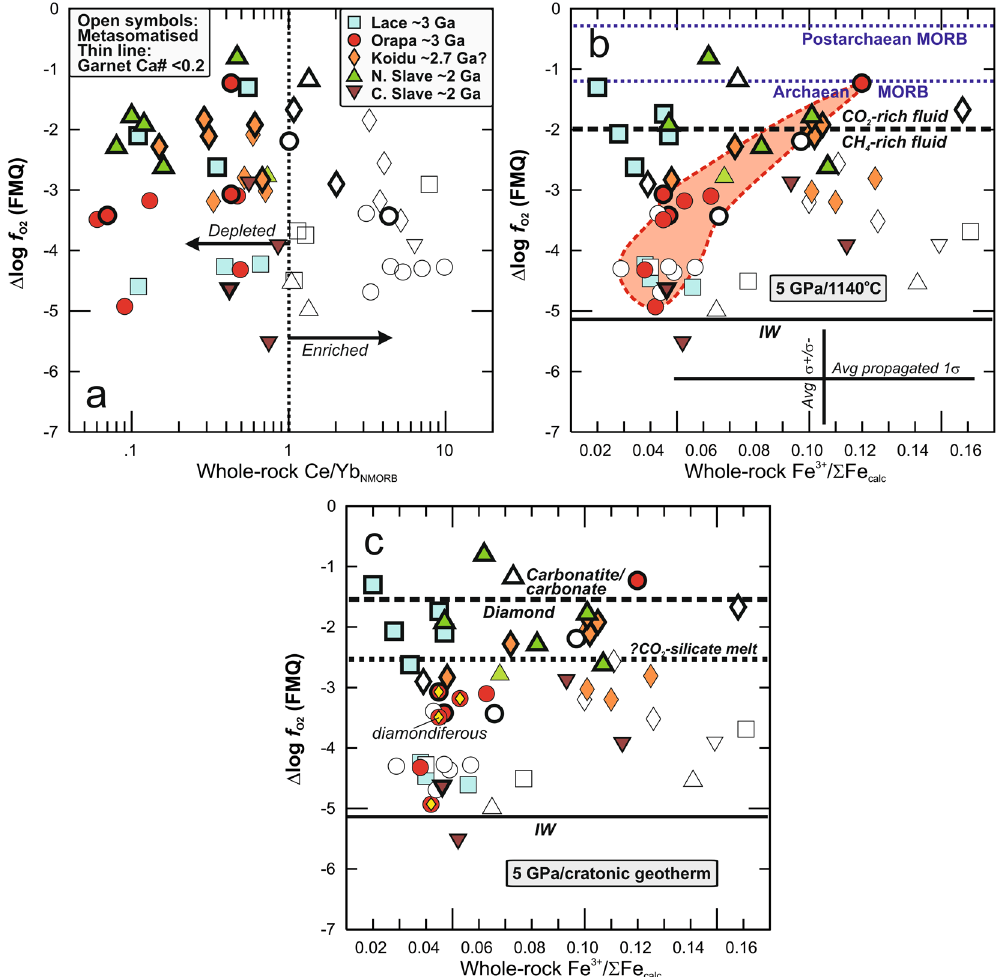
Figure 4. Oxygen fugacity estimates for mantle eclogite. Oxygen fugacity using the oxybarometer of 16 and denoted as ∆ log ƒ O 2 (FMQ), i.e. calculated relative to the fayalite-magnetite-quartz buffer, as a function of ( a ) NMORB-normalised Ce/Yb in reconstructed whole rocks (as in Fig. 1) and ( b,c ) Fe 3 + / Σ Fe in reconstructed whole rocks. Error bars on Fe 3 + / Σ Fe reflect average propagated uncertainties as described in Fig. 1, on ∆ log ƒ O 2 they reflect average uncertainties propagated from those on garnet Fe 3 + / Σ Fe ( ± 0.01). The symbols of samples with compositions far from the end-members on which the oxybarometer was formulated are shown with thin outline (see Methods). Thick stippled line in ( b ) separates CH 4 -dominated from CO 2 -dominated diamond-saturated fluid; ƒ O 2 corresponding to the iron-wuestite (IW) oxygen buffer is also shown (at 5 GPa and 1140 °C 31 ). Thin blue stippled lines show Δ log ƒ O 2 of post-Archaean and Archaean MORB-equivalents with FMQ-0.26 ± 0.44 and FMQ- 1.19 ± 0.33, respectively 8 . The majority of samples have lower ƒ O 2 than Archaean or modern MORB, requiring reduction of their protoliths upon subduction. Thick stippled line in ( c ) separates carbonatite melt or carbonate from graphite or diamond (at 5 GPa along a cratonic geotherm 13 ). Most Palaeoproterozoic and Archaean eclogites at mantle depth would not be in equilibrium with pure carbonatite melt, but could exist with a carbonated silicate melt, by analogy with the peridotite system 3 . Diamondiferous Orapa eclogites are indicated by yellow